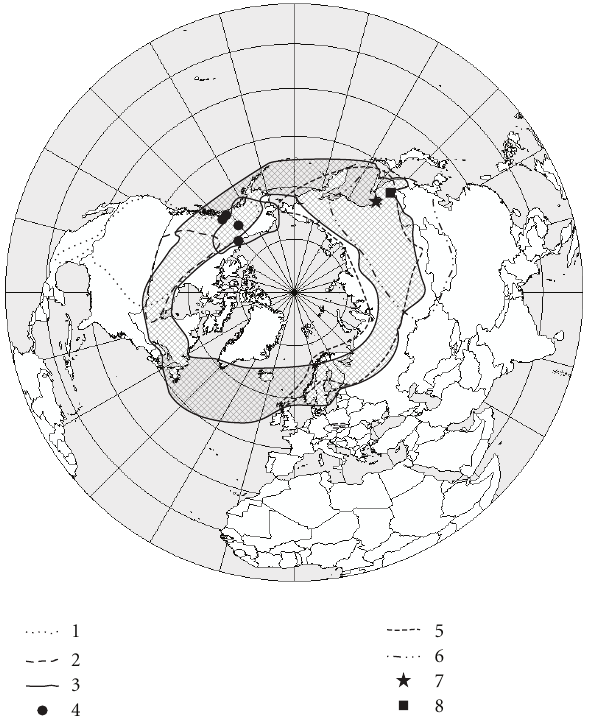
Figure 1: Distribution of Arphia conspersa (1), Sphagniana sphagnorum (2), Aeropodellus arcticus (3), Xanthippus brooksi (4), Tetrix fuliginosa (5), Chorthippus fallax (6), Ch. shantariensis (7), and Paracyphoderris erebeus (8) relative to the boreal zone (cross- hatching) (see text and references for details). The boundaries of the boreal zone based on [1, 2, 5] with some minor changes and simplification. The basic map is “Northern Hemisphere of Earth (Lambert Azimuthal projection)” by Sean Baker from http://commons.wikimedia.org/wiki/file:Northern Hemi- sphere LamAz.png, under the CC-by-2.0